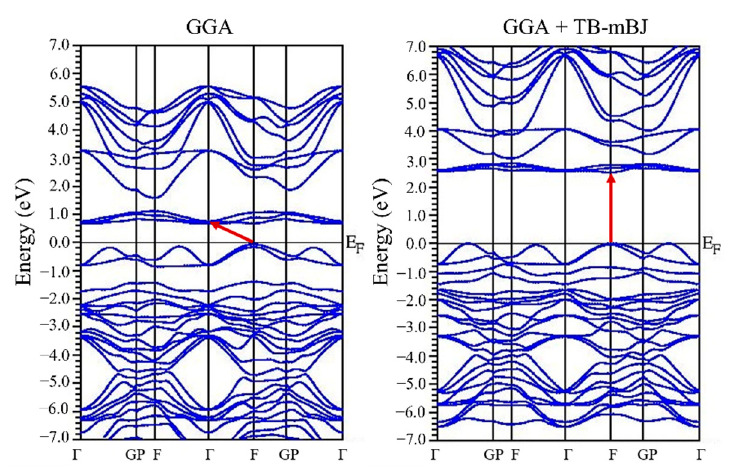
Figure 9. Band structure of BiFeO 3 computed using GGA, and GGA + TB-mBJ.